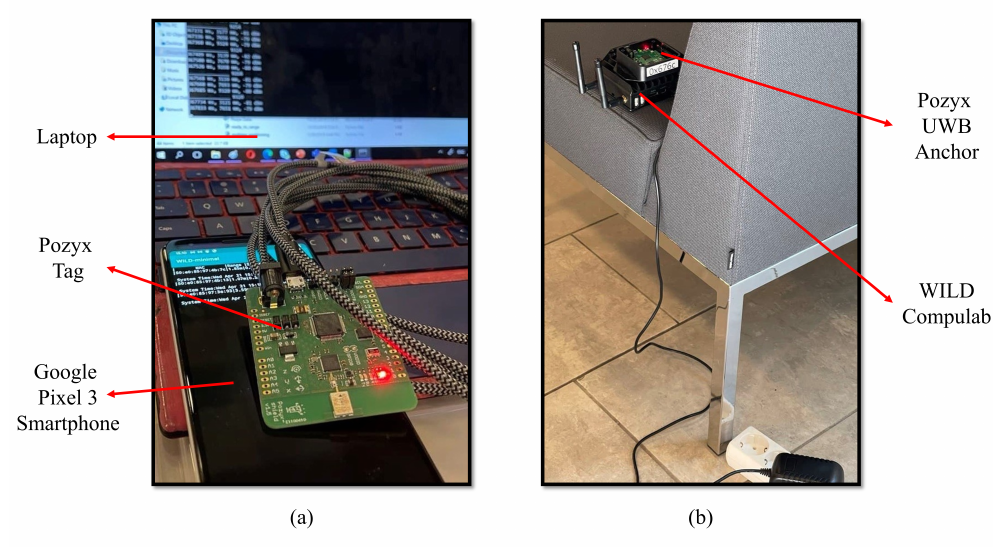
Figure 11. ( a ) The devices used for data collection on the UE side. ( b ) Configuration of devices at the location of one